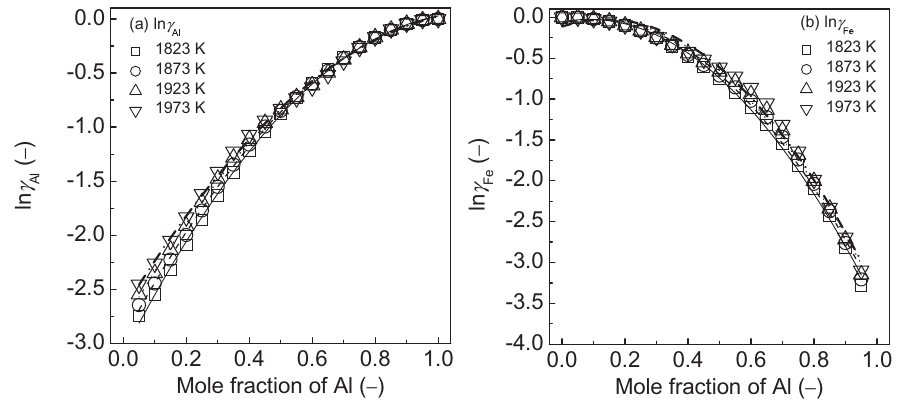
= ln N Al = x Al ð Þ of Al (a) or ln γ = ln N Fe = x Fe ð Þ of Fe Al Fe